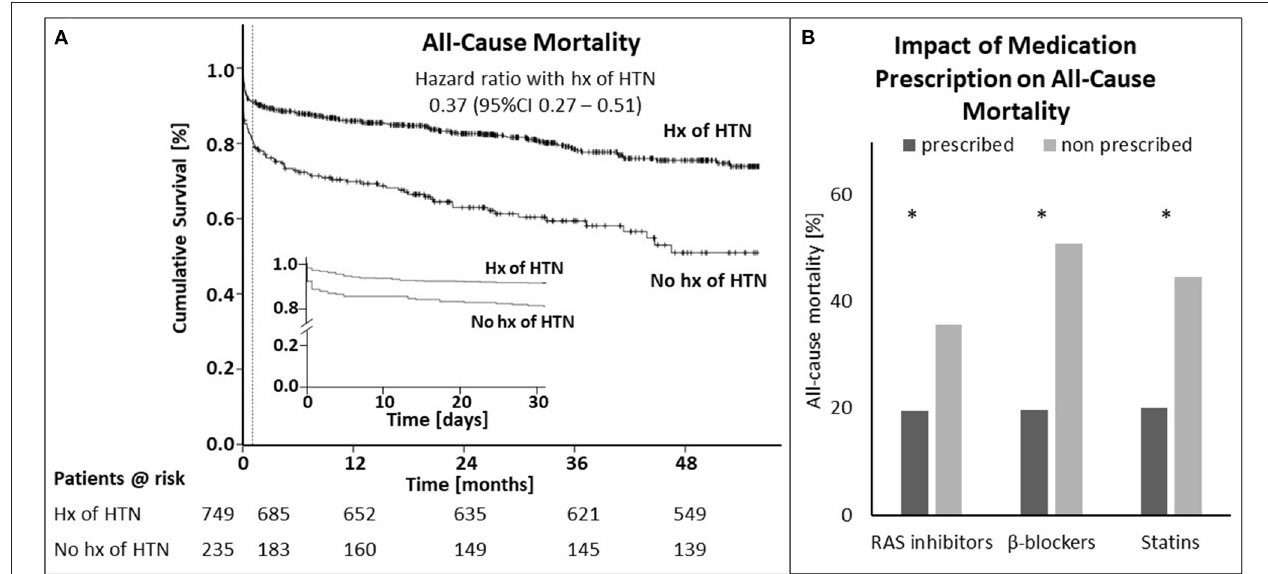
FIGURE 2 | History of hypertension elicits survival benefit after STEMI. (A) Shown is the cumulative survival for patients with and without history (hx) of hypertension (HTN) from admission to end of follow-up (A) and during the first 30 days [ (A) , inset]. The dotted line in (A) marks the 30-day time point. (B) Displays the impact of prescription of RAS inhibitors, β -blockers and statins for the whole cohort, except for patients who died within 24h after admission to the hospital on mortality for. Asterisks indicate significance ( p < 0.05). STEMI—ST-elevation myocardial